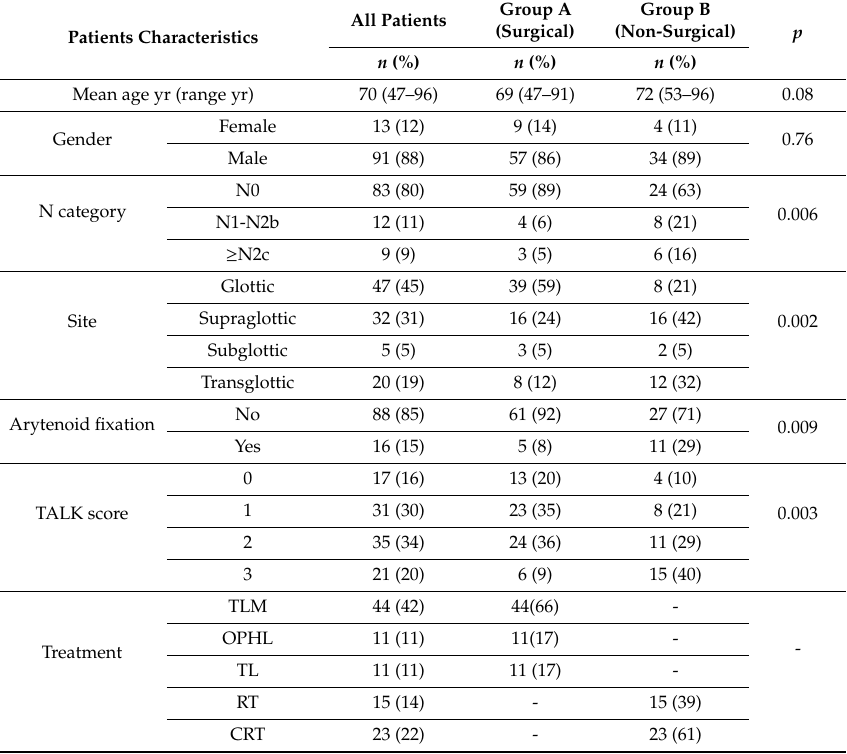
Figure 1. Decision strategy flow-chart. TLM, transoral laser microsurgery; OPHL open partial horizontal laryngectomy; TL, total laryngectomy; RT, radiotherapy; CRT; chemoradiotherapy. Table 1. Demographics and clinical data of the study population ( n = 104).